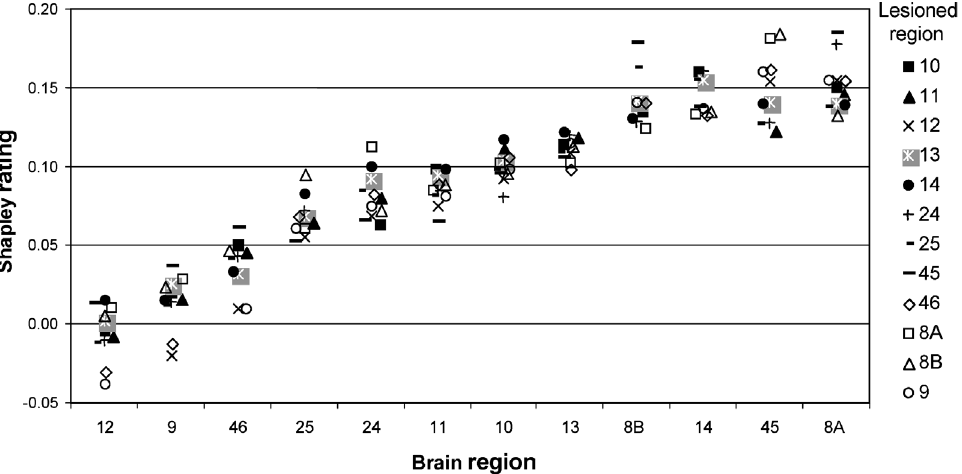
Figure 6. Shapley ratings for brain regions in the W40-2 network ordered along the abscissa by increasing mean Shapley values. For each of these brain regions, the different shapes represent the Shapley values obtained for subgraphs induced by the elimination of a particular brain region (symbols explained on the